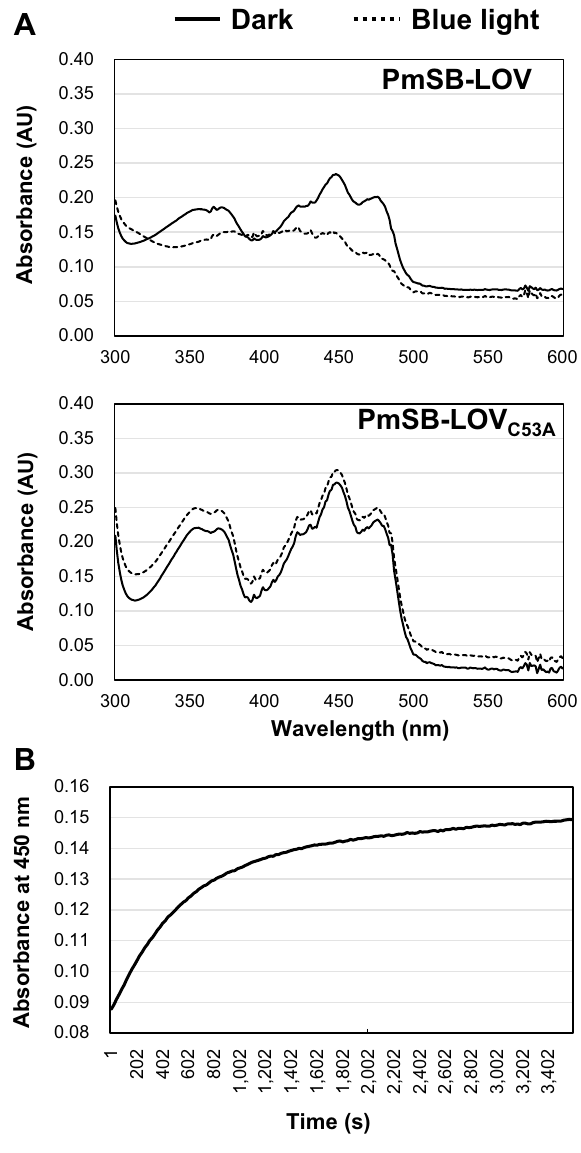
Figure 3. Absorption spectra of PmSB-LOV. ( A ) The absorbance spectra of the dark state and photoequilibrium (10 s of blue-light illumination) of the wild-type PmSB-LOV (upper panel) and PmSB- LOV C53A (lower panel) are shown by the solid and dashed line, respectively. ( B ) Dark state recovery of the wild type PmSB-LOV. Measurements of dark state recovery rates were taken every 20 s for 1 h by tracing absorbance at 450 nm. Two independent experiments in technical replicates were performed, and representative data were